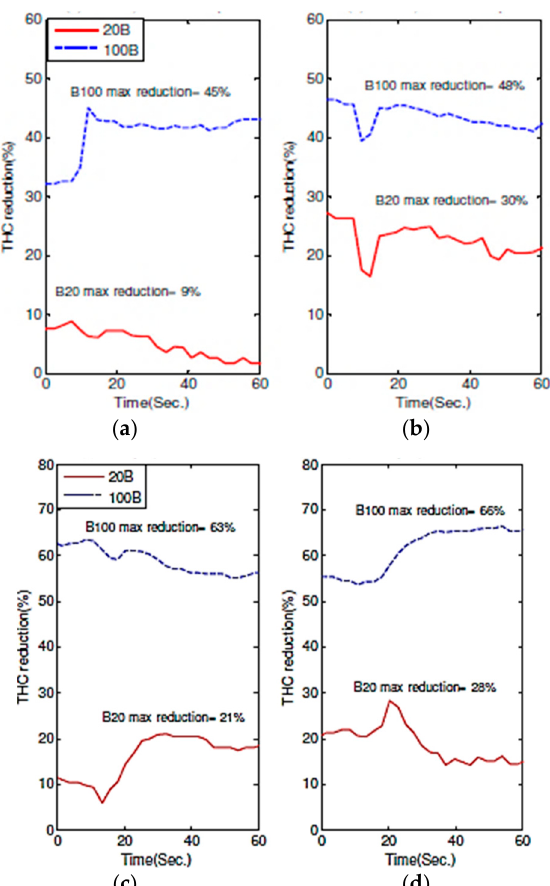
Figure 20. Percent reduction in THC emissions in the CI engine running with 20B blend and 100B during ( a ) positive and ( b ) negative speed transient conditions at 420 Nm torque. Percentage of THC emission reduction of the CI engine at ( c ) positive and ( d ) negative torque transition conditions at a constant engine speed of 1500 rpm.